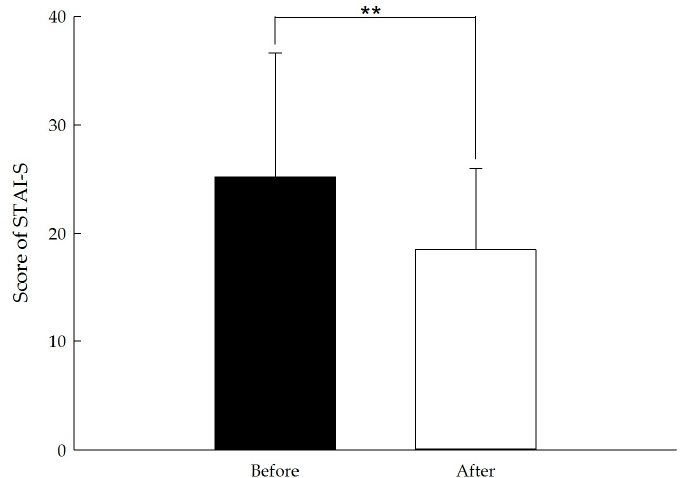
Figure 7. STAI-S score before and after the short forest bathing program. N = 128, mean ± standard error. ** p < 0.01, paired-sample t test.